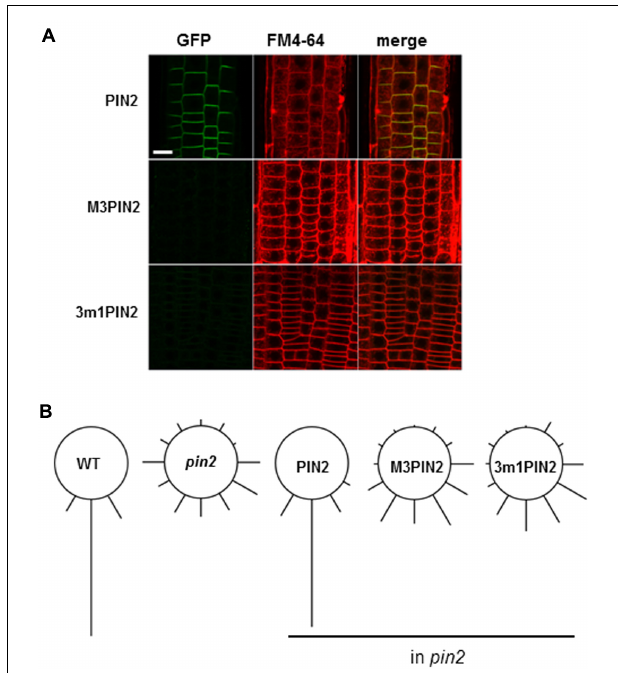
FIGURE 6 | The effect of M3 or 3m1 mutation on PIN2 trafficking and PIN2-mediated root gravitropism. (A) Representative confocal images of the root epidermal cells of homozygous pin2 complemented with PIN2 ( ProPIN2:PIN2:GFP ), M3PIN2 ( ProPIN2:M3PIN2:GFP ), and 3m1PIN2 ( ProPIN2:PIN2:GFP ). Bar = 5 µ m. (B) Relative degrees of root gravitropism of wild-type (WT), homozygous pin2 , and homozygous pin2 complemented with PIN2, M3PIN2, and 3m1PIN2 after 24-h gravitropic stimulation ( n = 44–135 seedlings).